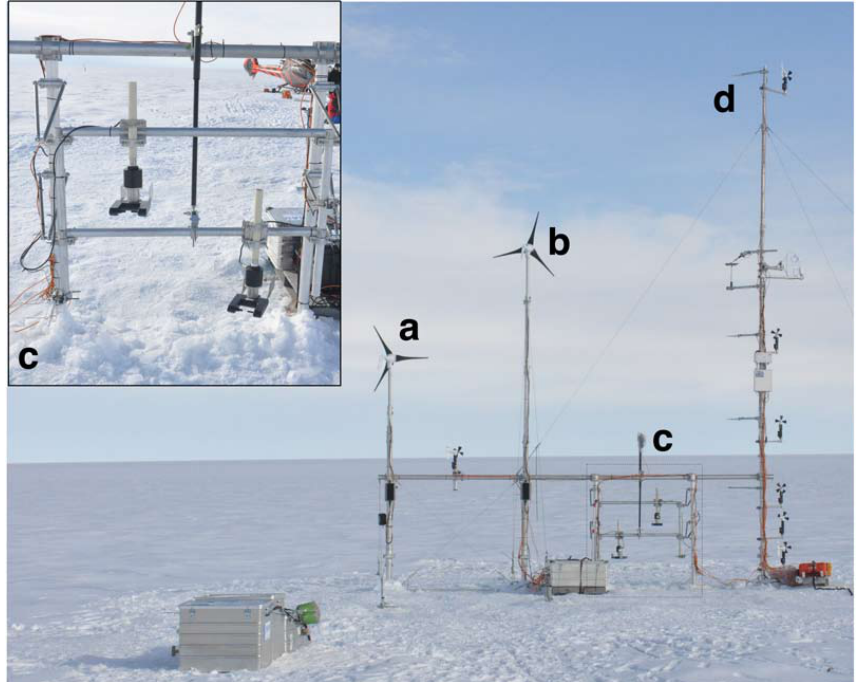
Fig. 3. Drifting snow equipment. Picture taken on 13 August